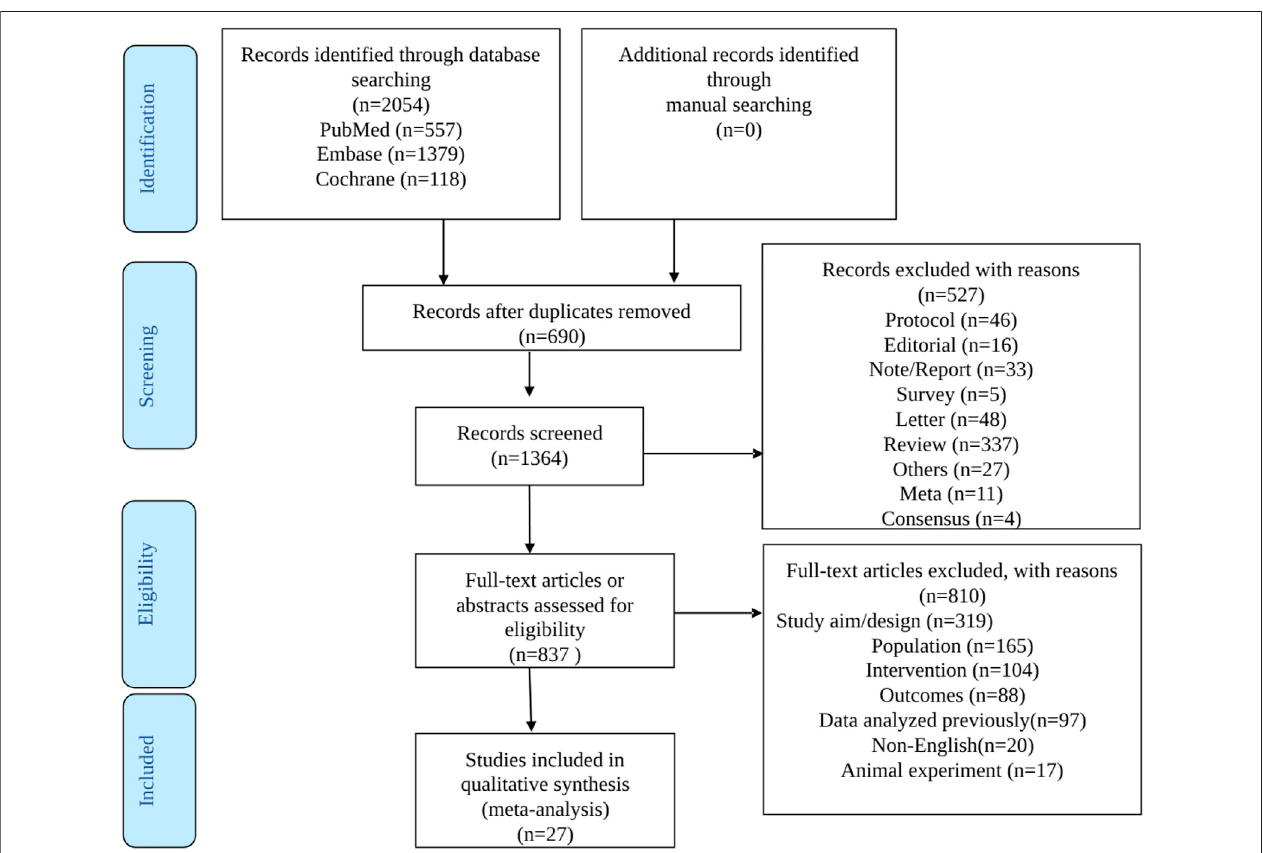
FIGURE 1 | Study selection process